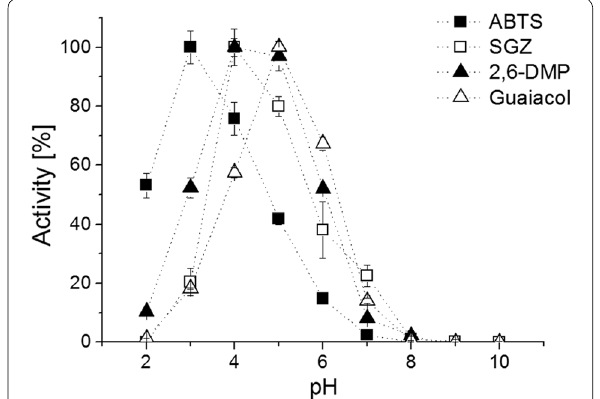
Fig. 2 pH optimum of Mrl2 in reactions with the substrates ABTS, SGZ, 2,6‑DMP and guaiacol. The highest measured activity for each substrate was set to 100%